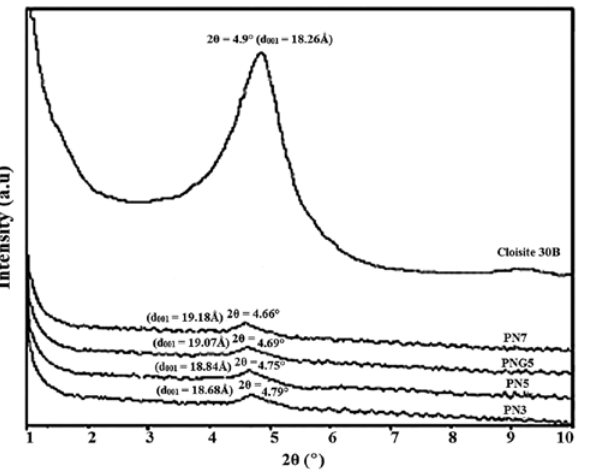
Figure 4: The mixing torque traces of P1 blend and PN3, PN5, and PN7